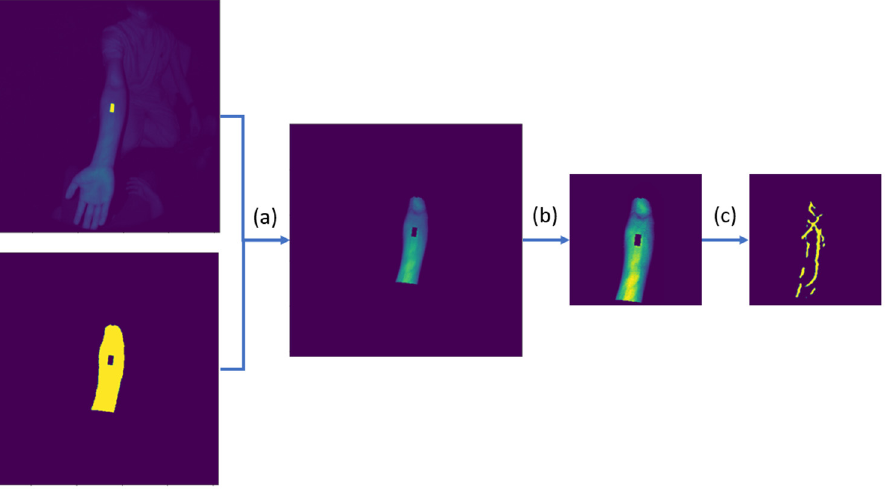
Figure 4. Overview of Vein Segmentation pipeline (with sample intermediate and final outputs). Arm masking is done on the NIR image ( a ), followed by image preprocessing to normalize and increase contrast for the pixel values ( b ), and the final CNN vein segmentation ( c ).